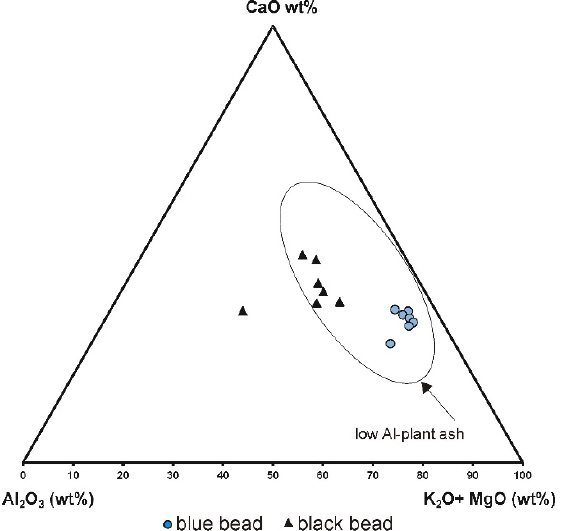
Figure 14. Al 2 O 3 –CaO–K 2 O+MgO ratio diagram [20] of the two glass beads analysed by EDS.